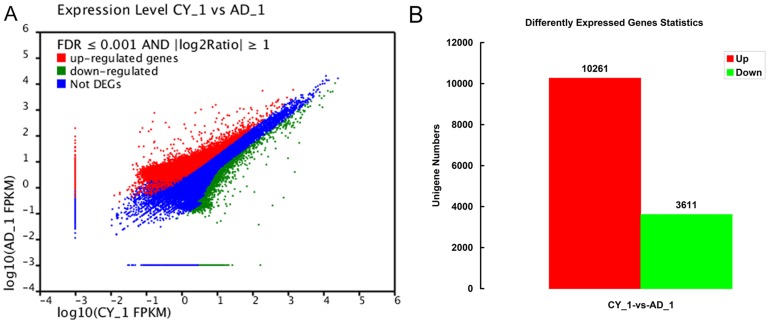
Expression level and statistics of the differentially expressed genes (DEG) in artificial diet-fed (AD_1) vs. prey-fed (CY_1) treatments.(A) Expression level of DEG. (B) Statistics of DGE. In total, the expression levels of 54,977 genes were affected by the artificial diet. Of which, 13,872 DEGs had significantly differential expression levels (FDR ≤ 0.001 and |log2Ratio| ≥ 1). Among them, 10,261 and 3,611 genes were up-regulated and down-regulated, respectively in AD_1 vs. CY_1.